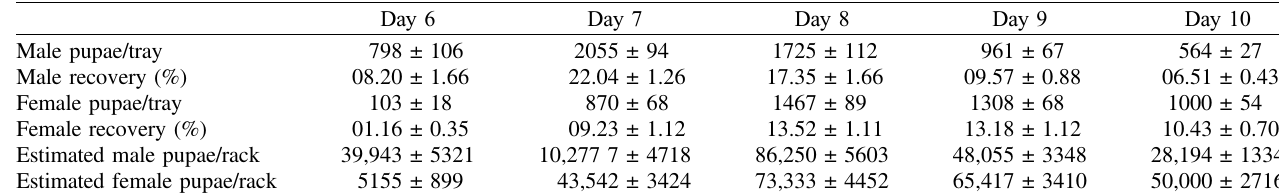
Figure 3. Number of (A) male pupae, (B) female pupae, and (C) total pupae as a function of the day of pupae collection in Aedes aegypti. Signi fi cant variation in the number of pupae collected as a function of the day of collection. Data presented in the fi gure are expressed as mean ± SE. Table 2. Rack pupal production estimation in Aedes aegypti using the FAO/IAEA larval diet and feeding